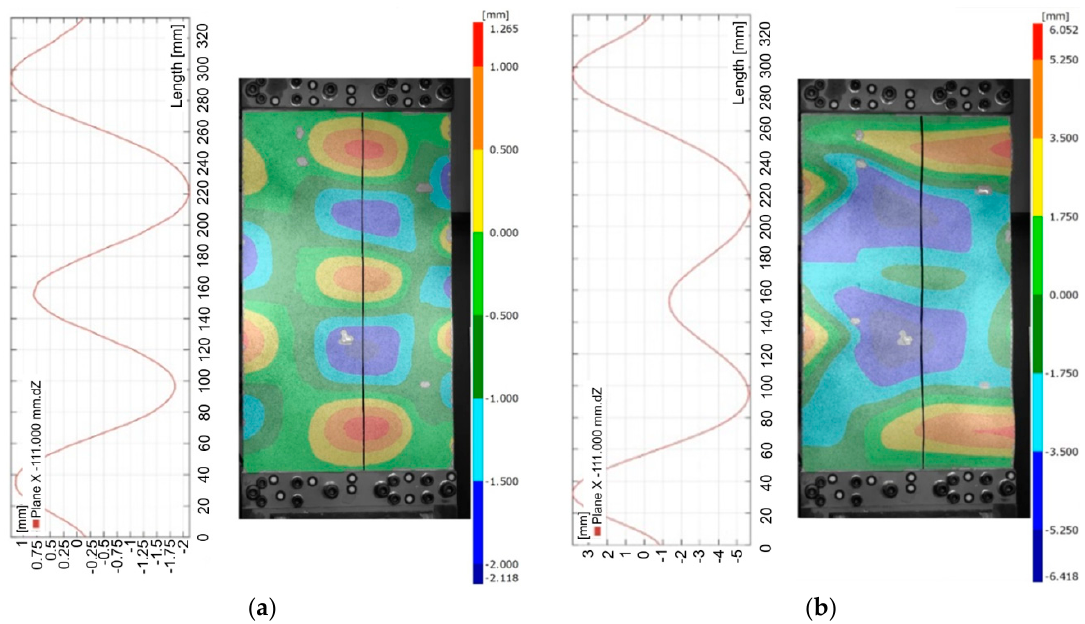
Figure 5. Deflection of riveted panels subjected to a compression load of 24 × 10 3 N ( a ) and 43 × 10 3 N ( b ) obtained using the three-dimensional DIC technique.